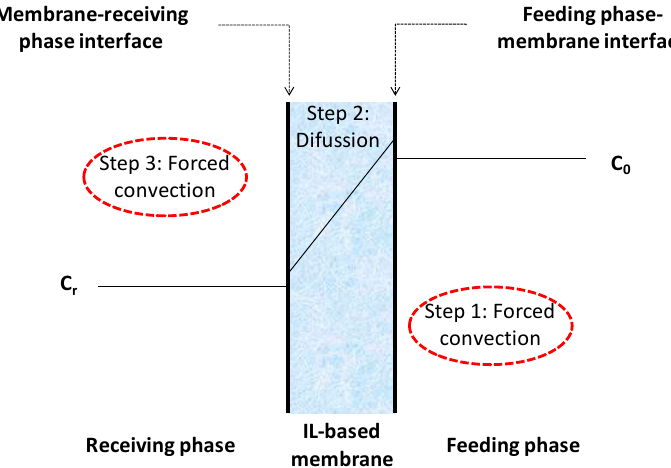
Figure 2. Transport of nutrients through polymer ionic liquid inclusion membranes (PILIMs) based on solution-diffusion model.